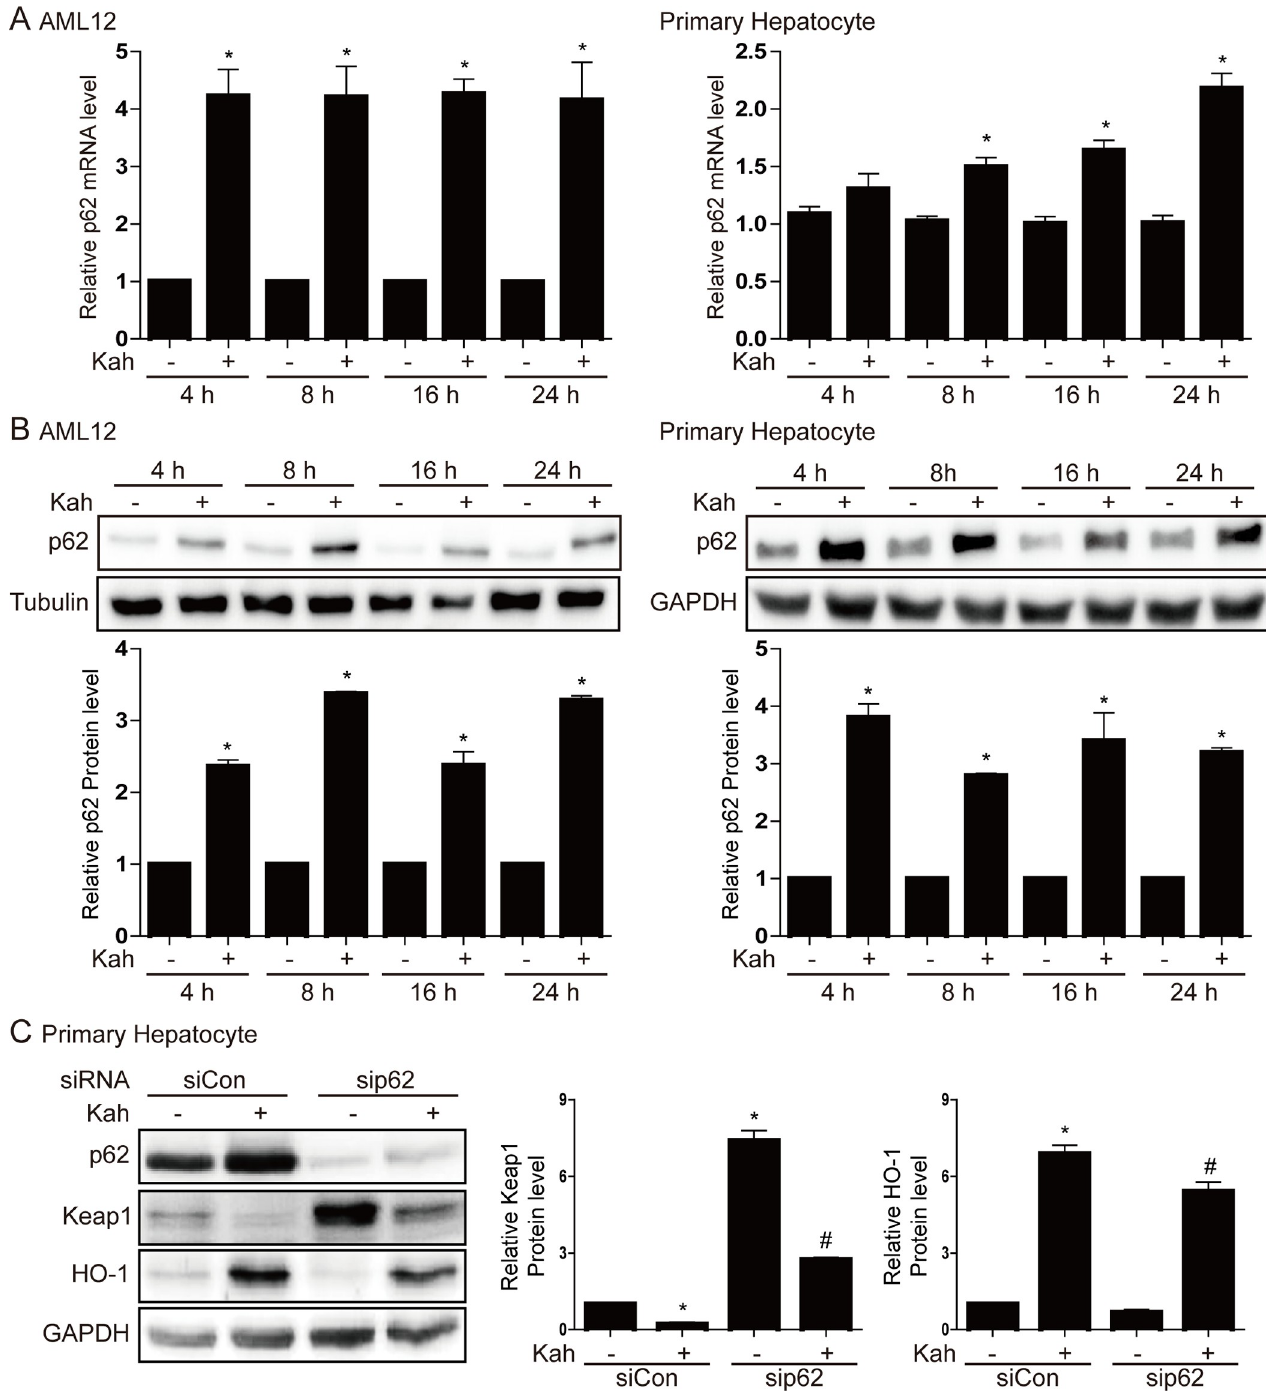
Fig 4. The effect of kahweol (Kah) on p62 expression. AML12 cells were treated with 20 μ M kahweol and primary hepatocytes were treated with 40 μ M kahweol. ( A,B ) Real-time RT-PCR ( A ) and western blot ( B ) analyses of p62 mRNA and protein levels, respectively, in AML12 cells (left) and primary hepatocytes (right). Data in the bar graph are means ± SEM of three independent measurements; � p < 0.05 compared with the control for each time. ( C ) Primary hepatocytes were transfected with a p62-specific siRNA (siRNA-p62; 100 nM) or a control siRNA (siCon; 100 nM), treated with 40 μ M kahweol for 24 h, and then analyzed by western blotting. Data in the bar graph are means ± SEM of three independent measurements. � p < 0.05 compared with the control siRNA. # p < 0.05 compared with the siRNA-p62.